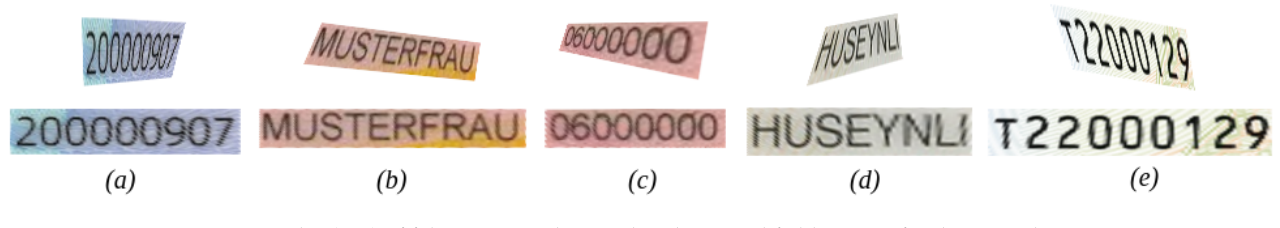
Figure 11. Examples ( a – e ) of false-positive distorted and restored field images for the second experiment.